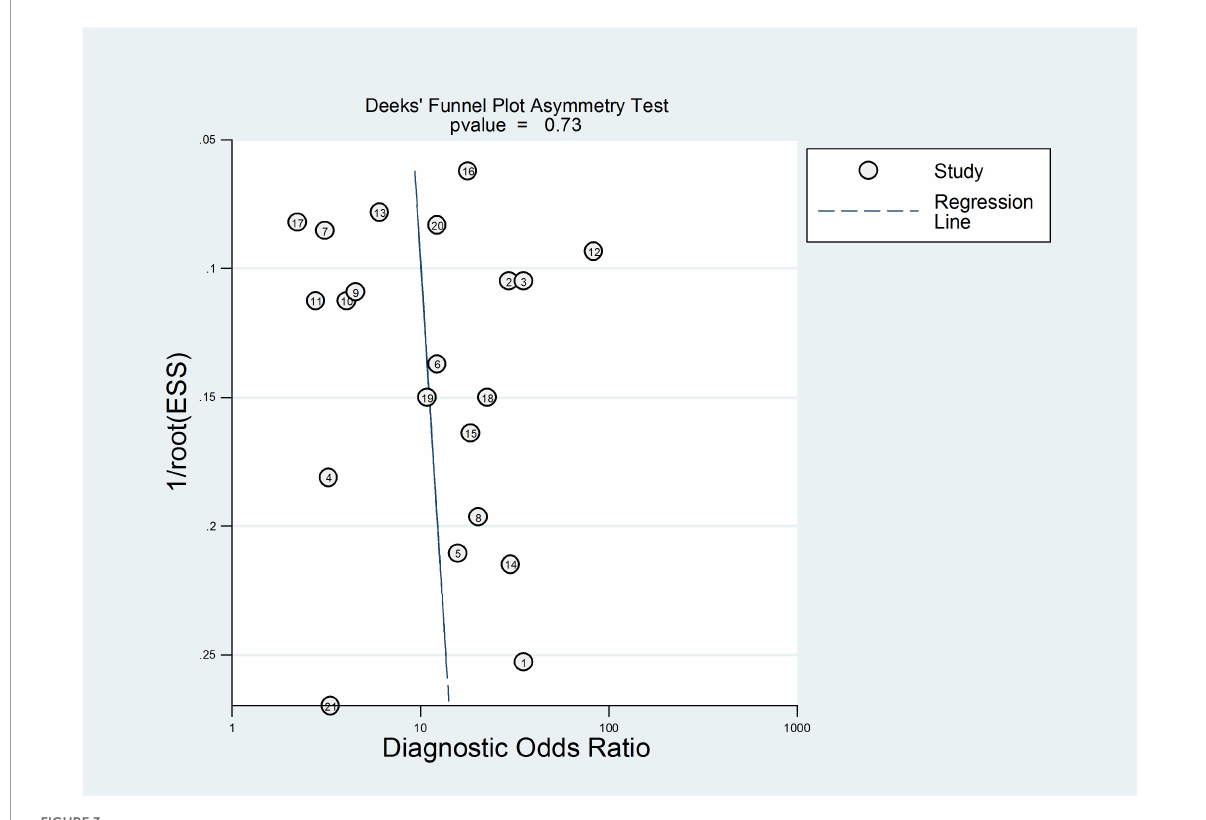
FIGURE3 Deek’s funnel plot assessment of potential publication bias.